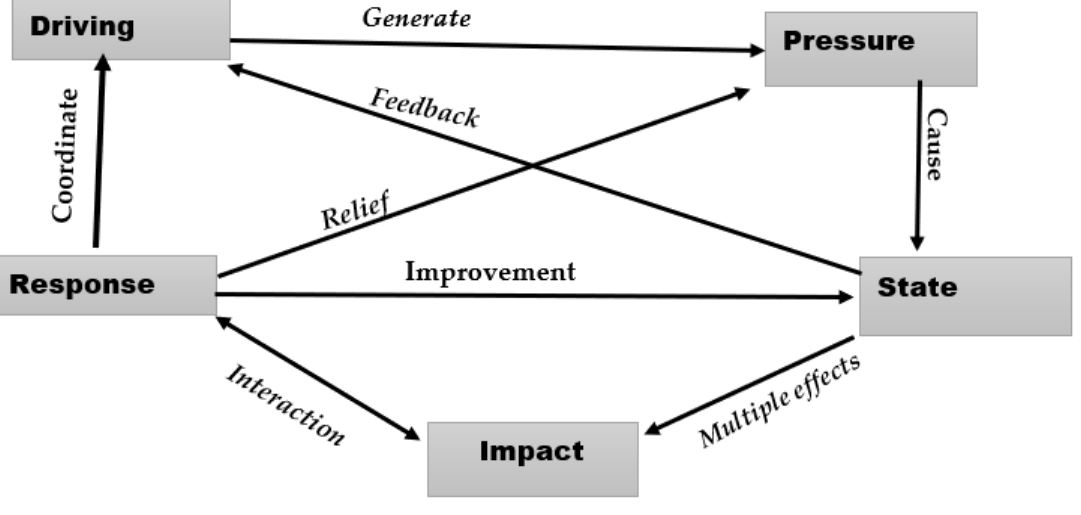
Figure 1. DPSIR conceptual framework.